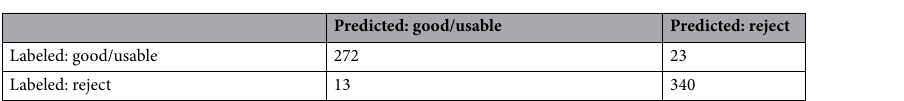
Figure 6. Inability of the proposed method to classify images with inadequate field definition. Top row shows four color fundus images from EyeQ training set and the second row are corresponding vessel segmentation images. OD is not visible in the FOV. A big FD value is obtained due to clear visibility of macular vessels. Original file names of the color fundus images are ( a ) “24871_left”, ( b ) “24871_right, ( c ) “34207_right” and ( d ) “38160_right”.